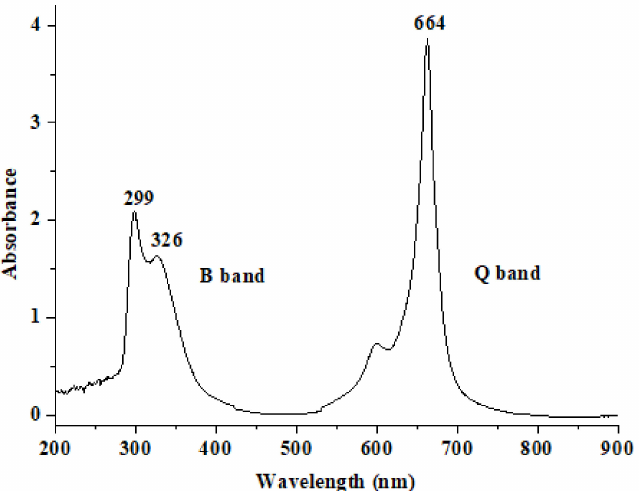
Figure 2. UV–VIS spectra of the free CoPcS catalyst (test sample of CoPcS DMF solution with the concentration of 1.0 × 10 − 6